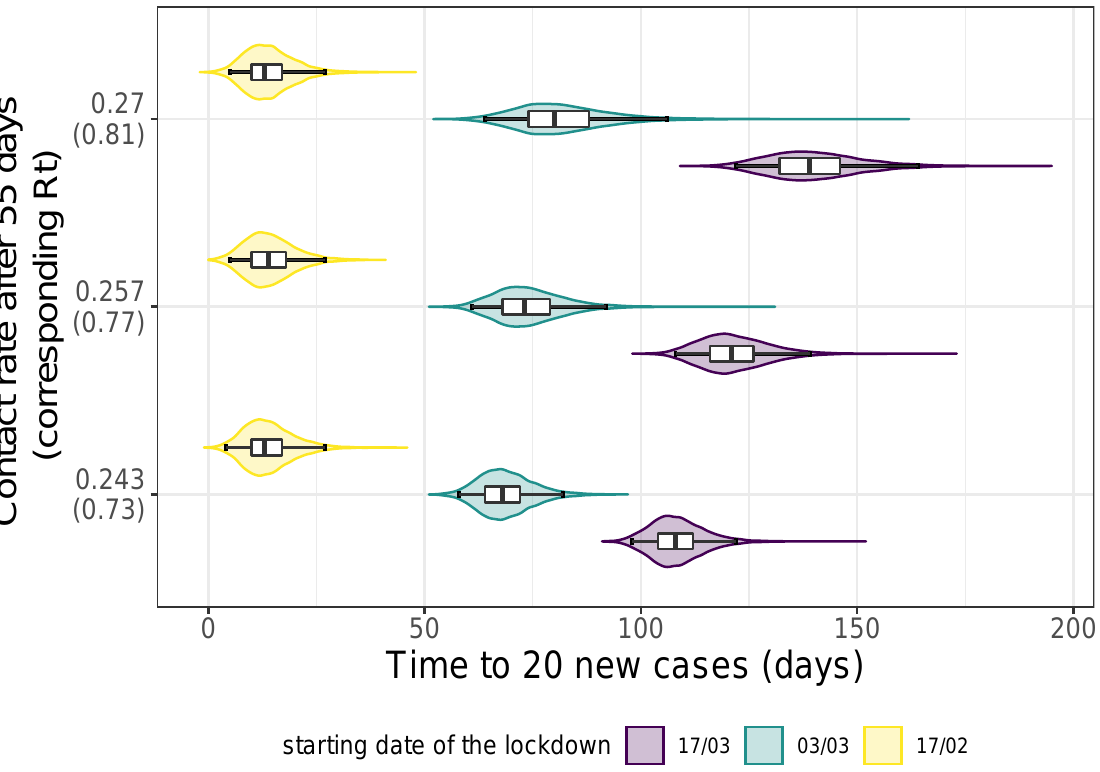
Figure 4 – Effect of the lockdown intensity, stochasticity, and initiation date on the time to 20 new cases under individual spreading heterogeneity assumption. The distributions of the time to 20 new cases (in days since the start of the lockdown) for several contact rate restrictions post 55 first days are plotted on the Y-axis using violin plots and box- plots. In this graph we assume individual spreading heterogeneity. The colors indicate the different initiation date of the lockdown: in purple it starts on Feb 17, green Mar 03 and yellow on Mar 17 (official start). The box extends from the lower to upper quartiles of the data. The whiskers expand from the 2.5% to the 97.5%